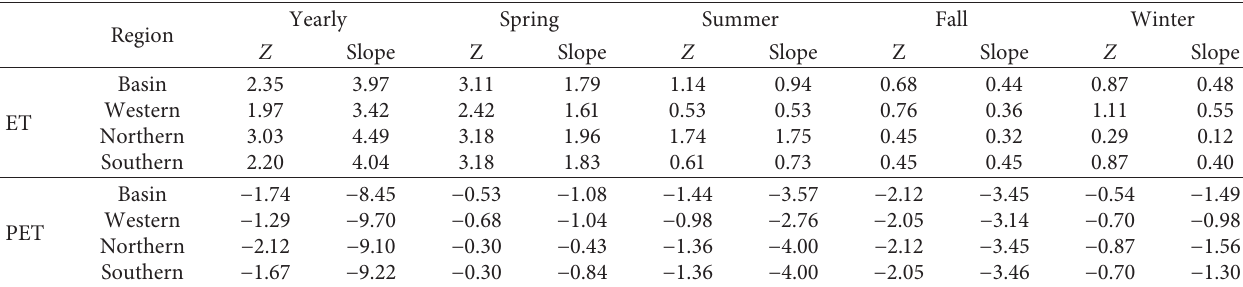
Table 1: Results of M-K test for annual and seasonal ET and PET in whole basin and subzones during 2001–2018 (slope unit: mm/year).